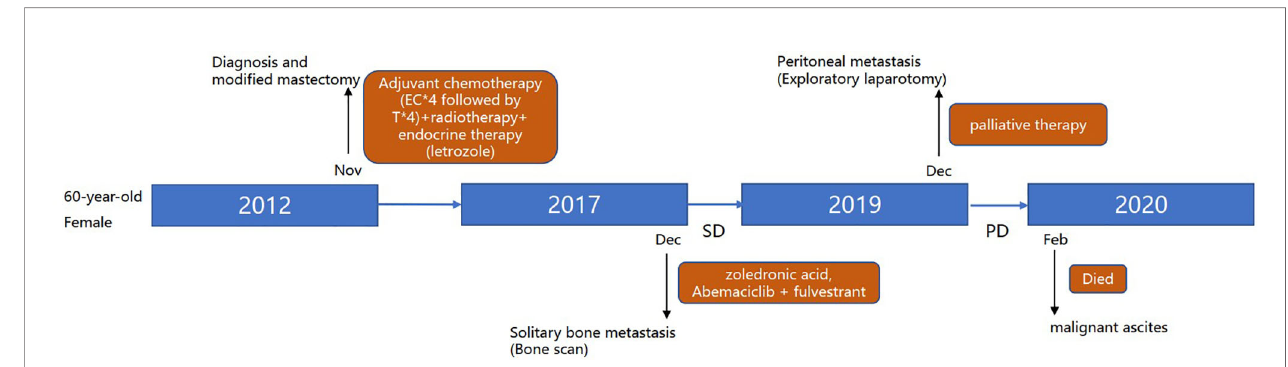
FIGURE 2 | Review of treatment process of the patient (from November 2012 to February